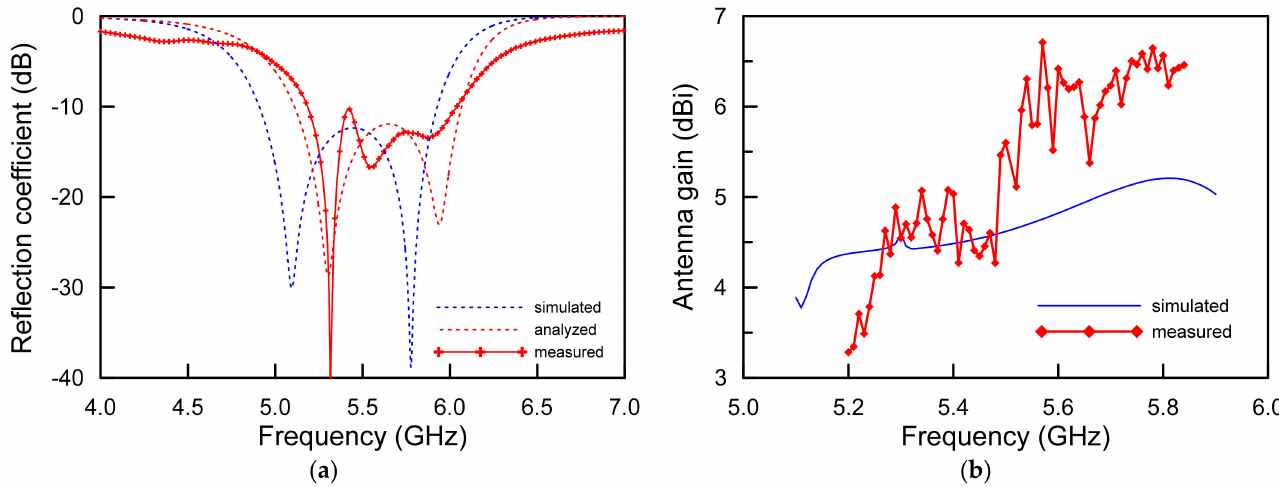
Figure 7. Simulated and measured results of the proposed antenna: ( a ) reflection coefficients and ( b ) realized antenna